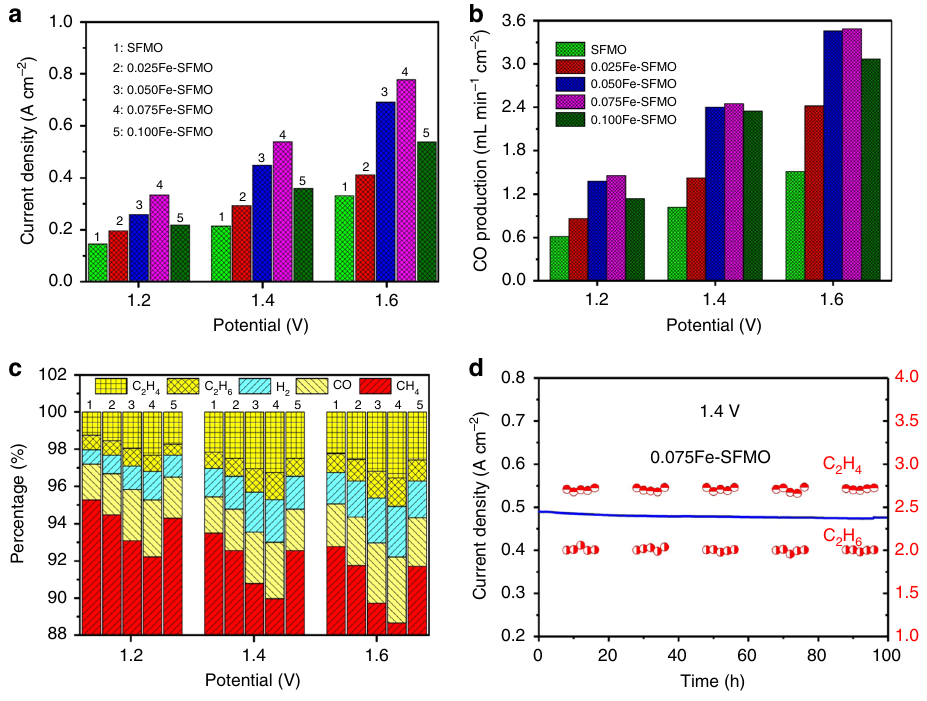
Fig. 5 Electrochemical oxidation of CH 4 in conjunction with CO 2 electrolysis. a The current – voltage ( I – V ) relationship of CO 2 electrolysis with CH 4 oxidation at 850 °C. b CO production in the cathode at various voltages. c The product analysis in the anode. d The long-term performance of the 0.075Fe – SFMO – SDC electrode for CH 4 oxidation with CO 2 electrolysis at 850